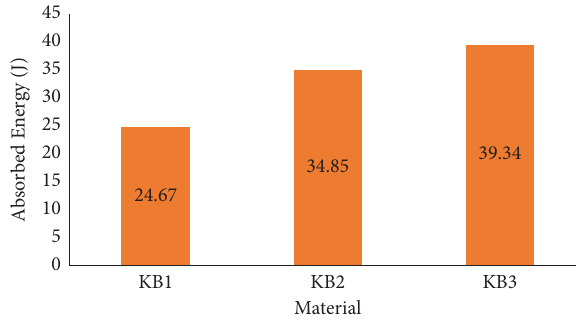
Figure 14: Absorbed energy vs. composite